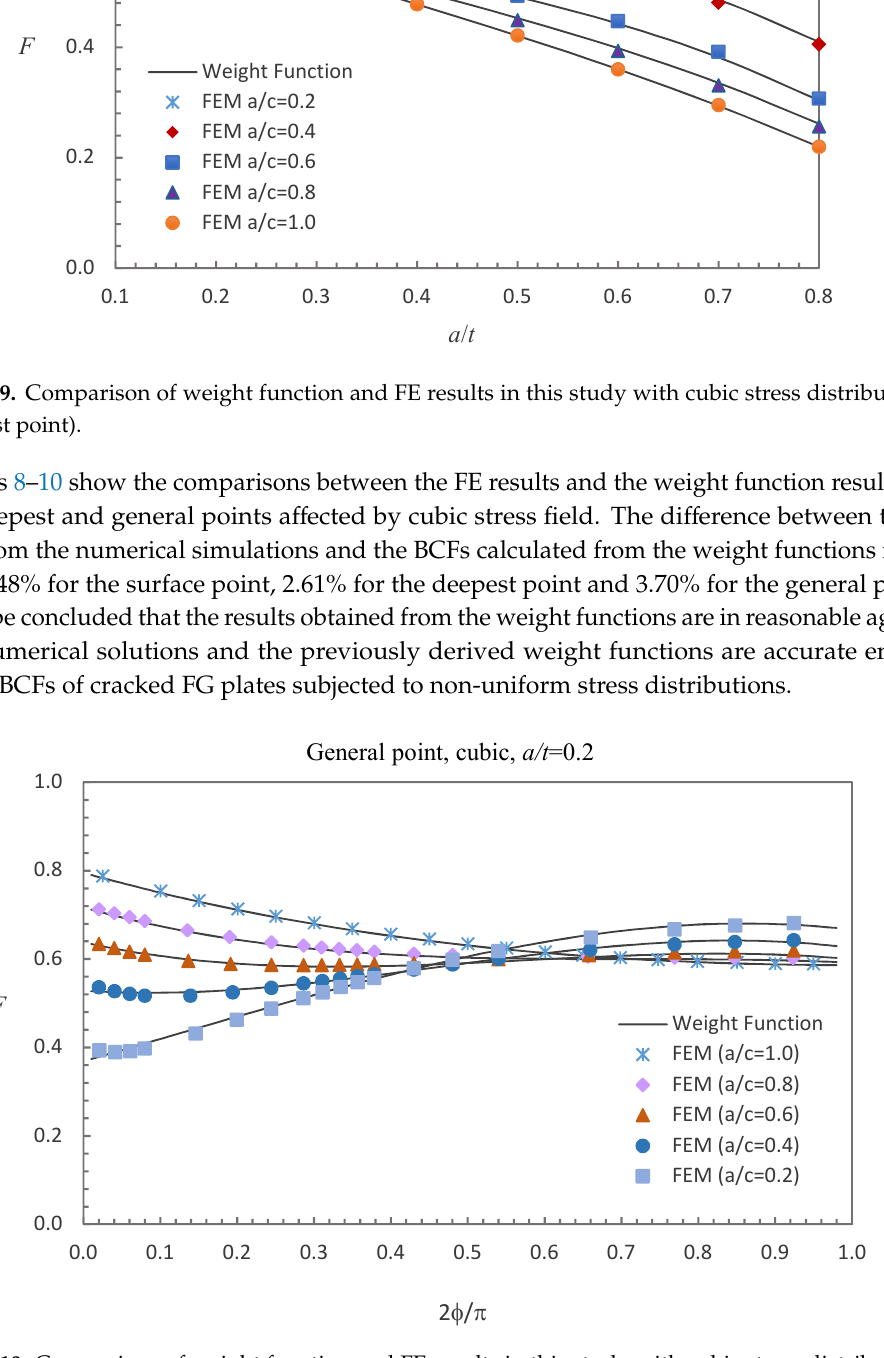
Figure 10. Comparison of weight function and FE results in this study with cubic stress distribution (general point).